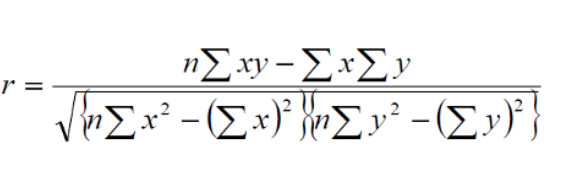
Table 5. Correlation coefficients of each trustworthiness indicator and trust value.